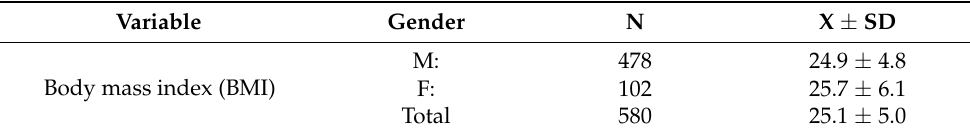
Table 2. BMI according to gender in the homeless people.